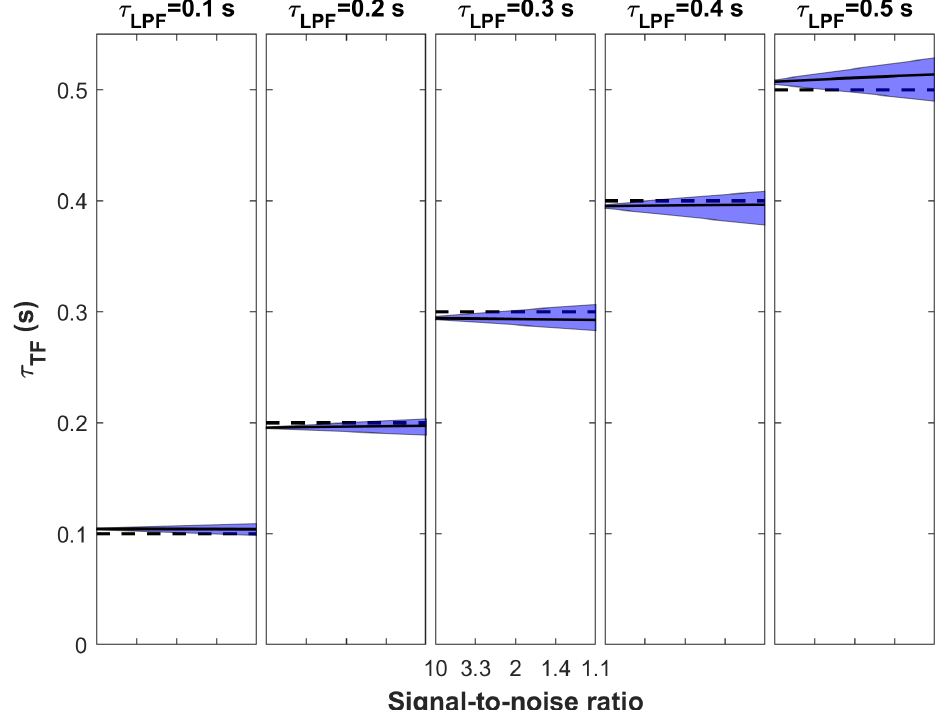
Figure 7. Time constants calculated using the cospectral approach, i.e. CSA √ , for several low-pass filtering conditions ( τ LPF = 0.1– H, sync 0.5s) as a function of signal-to-noise ratio (SNR) over the range 10–1.1, which corresponds to the amount of noise (e.g. 10%–90%). The solid black line represents the medians, while the shaded areas represent interquartile ranges. The dashed line corresponds to the expected value ( τ LPF ), which was used for the artificial low-pass filtering.